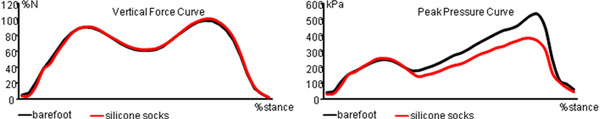
Vertical Force and Peak Pressure curves obtained by barefoot walking without (black) and with (red) silicone socks (curves have been averaged over 30 left steps).